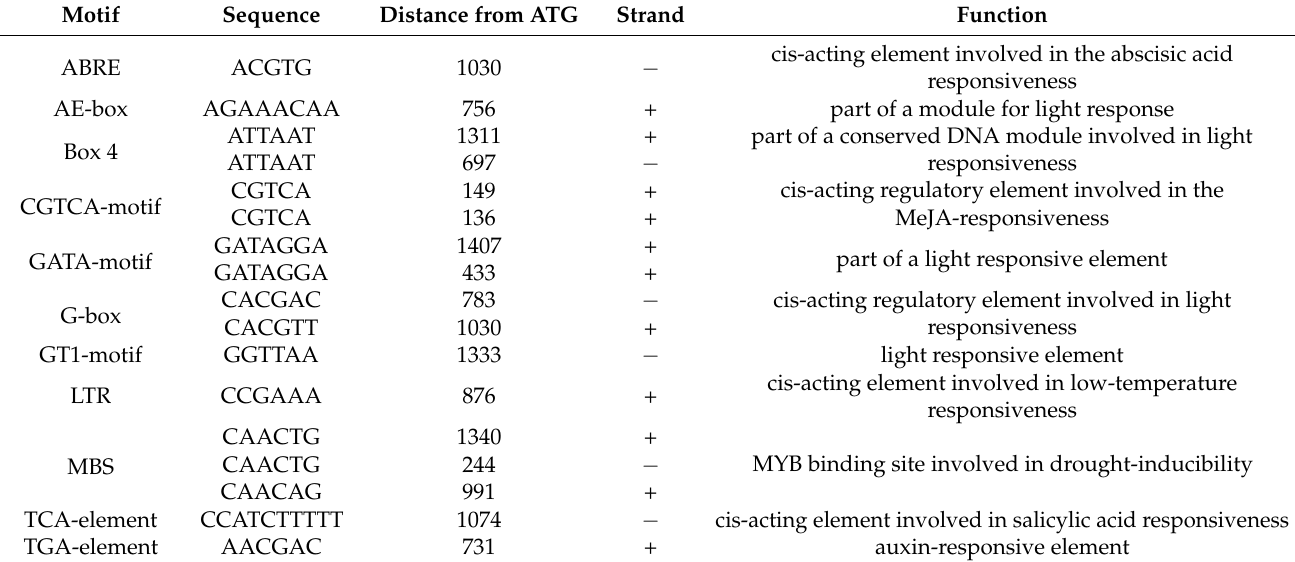
Table 1. Cis-acting elements within the promoter region of MiMYB1